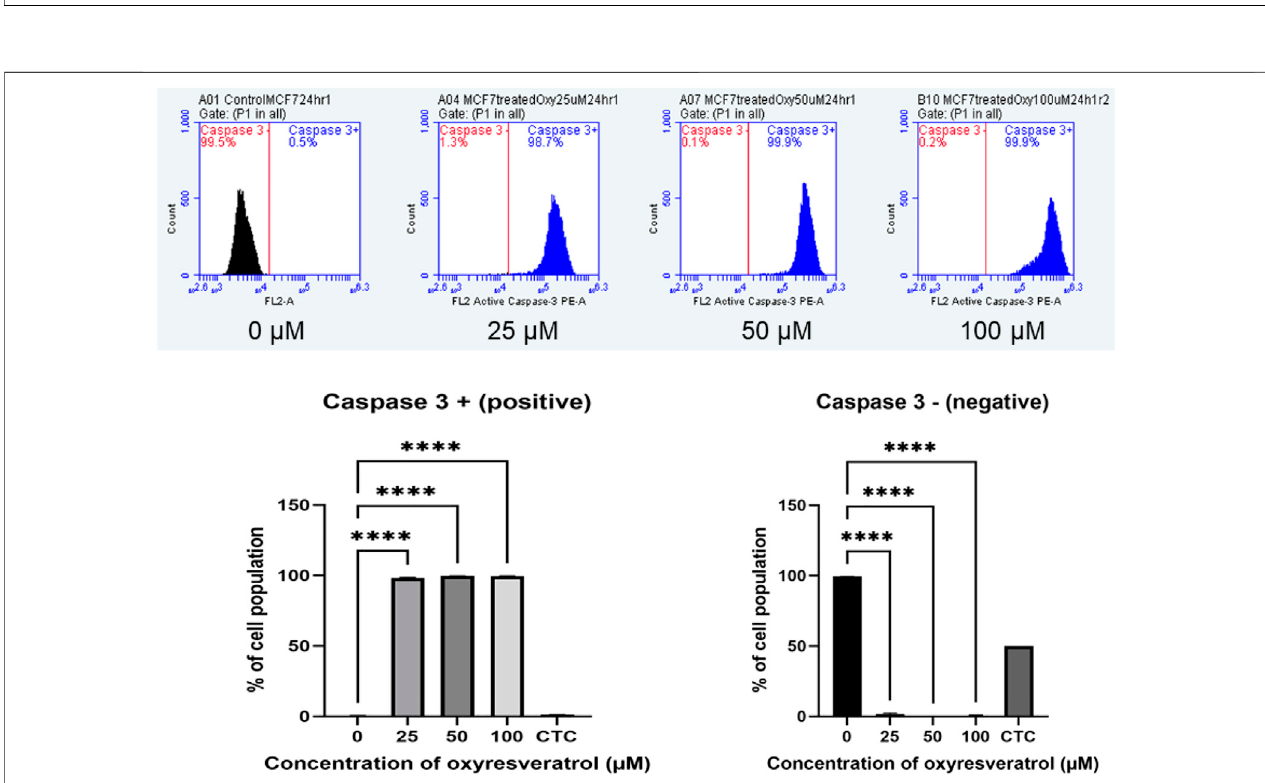
FIGURE 7 | Caspase – 3 expression in MCF-7 cells following exposure to various concentrations of OXY for 24 h and camptothecin (CTC) for 4 h. The cells were stained with anti – active caspase – 3 and analyzed by fl ow cytometry. Data are the mean ± SD of three experiments. Statistical analysis was carried out using One-way ANOVA analysis of variance followed by Dunnett ’ s test. The signi fi cant difference was compared relatively to the control (**** p < 0.0001).